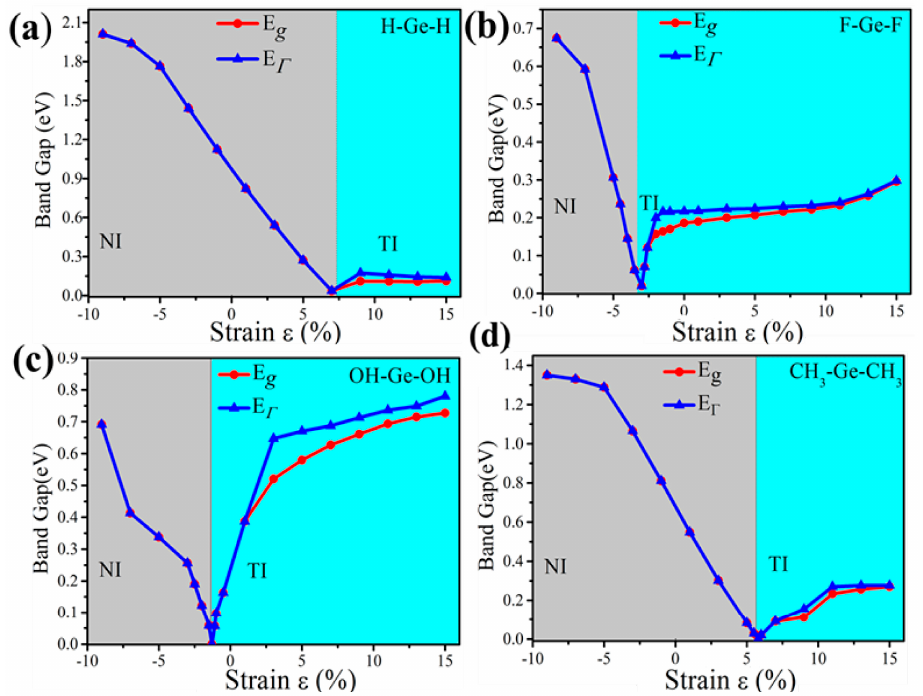
Figure 4. The calculated band gap at Γ point (E Γ ) and the global band gap (E g ) of ( a ) GeH; ( b ) GeF; ( c ) GeOH and ( d ) GeCH 3 with SOC as a function of external strains. Notably, the insets in panel show the trend of band gaps of TI phase as a function of external strain.